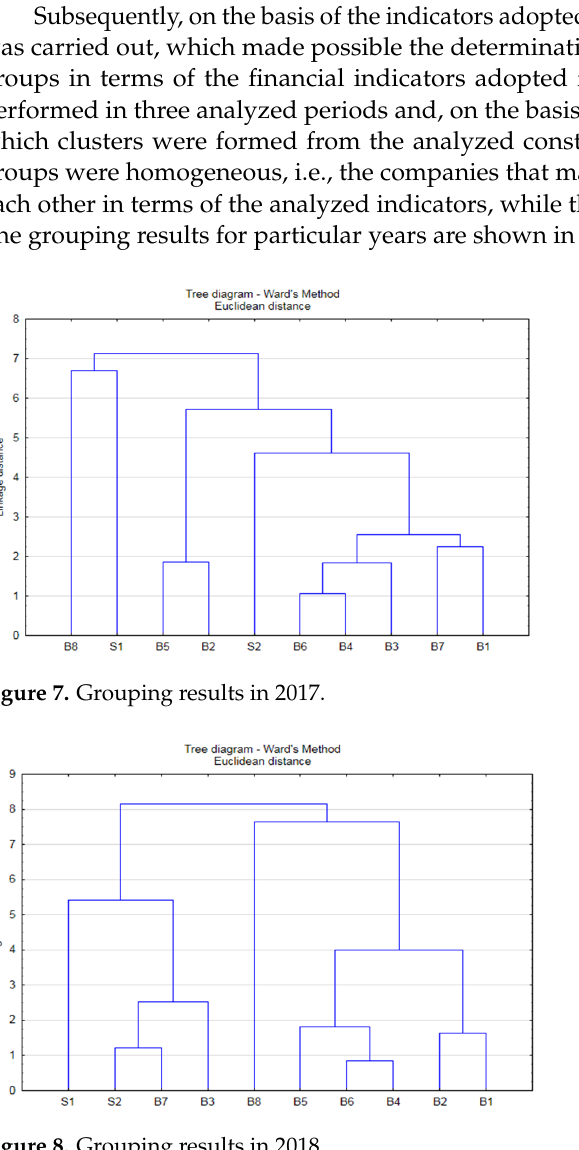
Figure 6. Profitability by company in 2017.